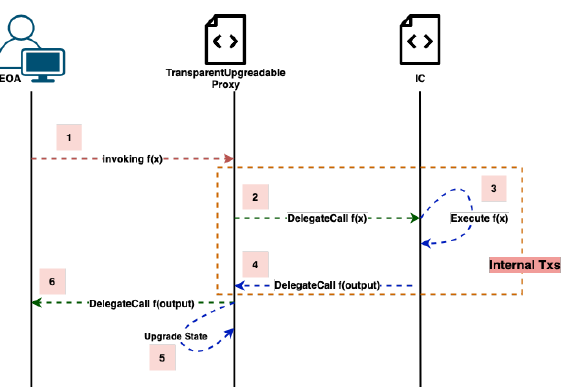
Figure 2. Invoking process of IC functions Upgrading the IC to a new version requires deploying the new version first and upgrading the address in proxy storage via ProxyAdmin contract. It is clearly shown in Figure 3